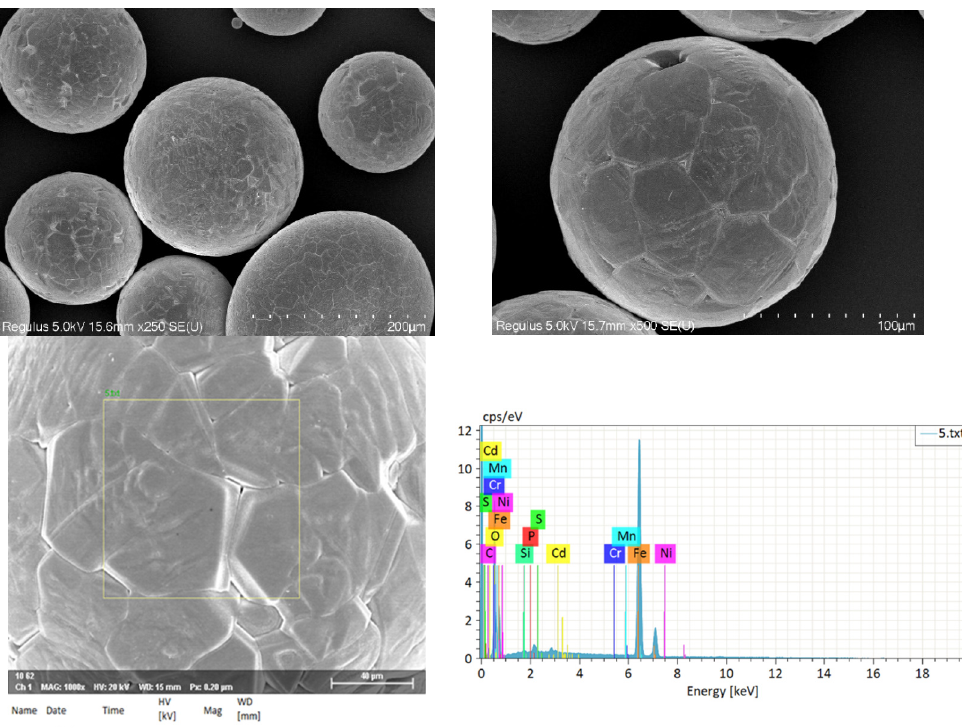
Figure 4. Particle matter released during the laser cutting of carbon steel.